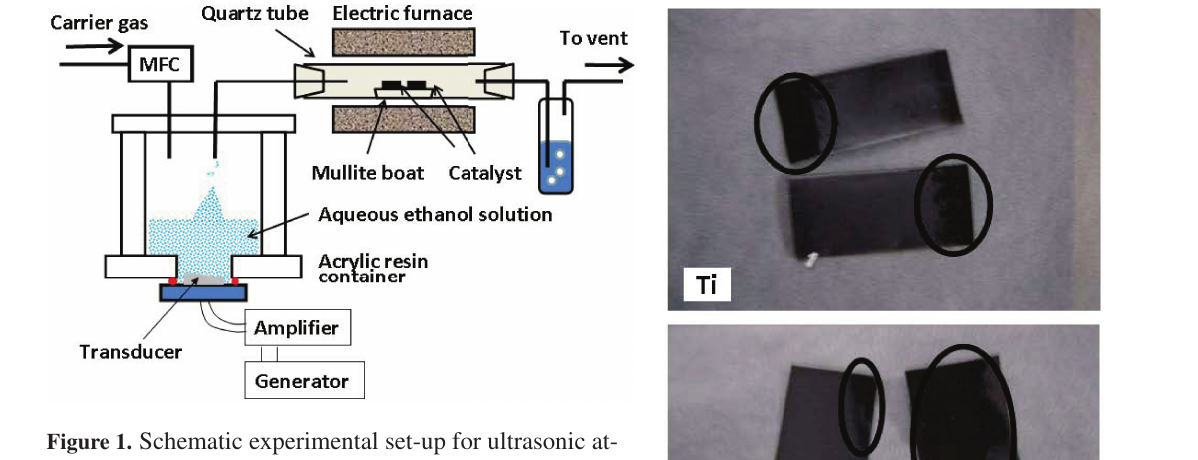
Figure 1. Schematic experimental set-up for ultrasonic at- omization and pyrolysis treatment.